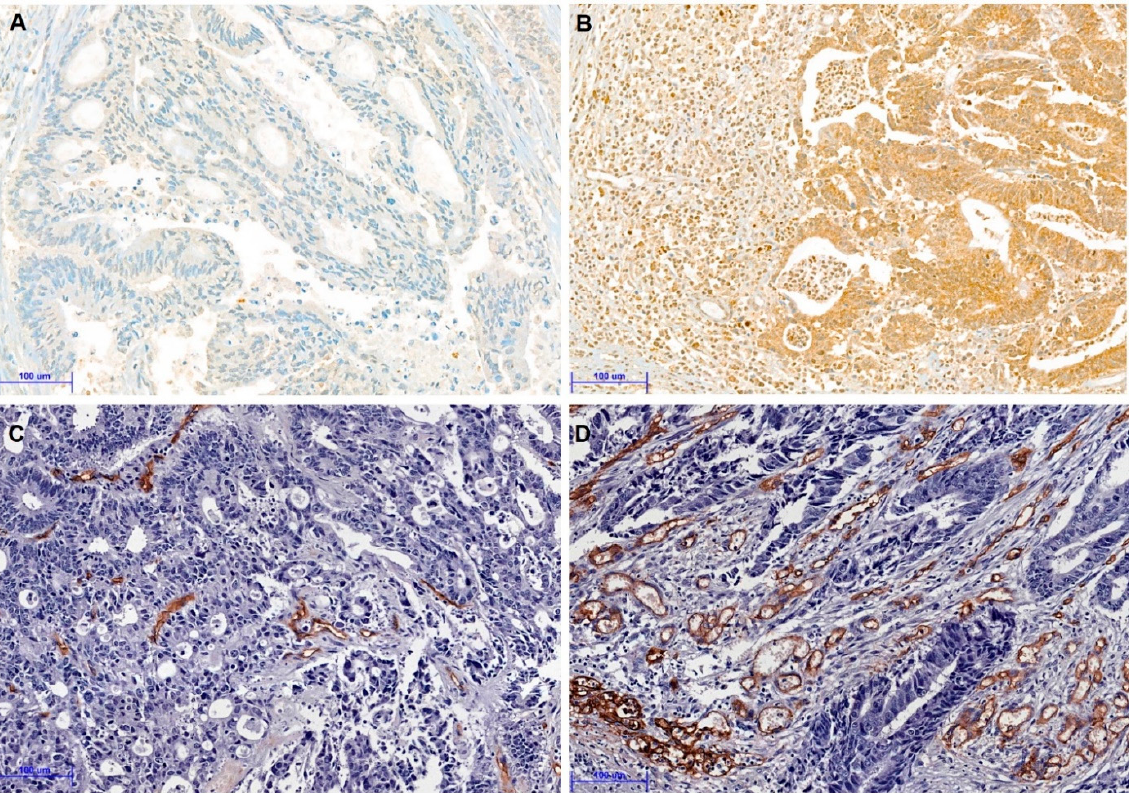
Figure 2. Representative immunohistochemical images for hypoxia-inducible factor-1 α (HIF-1 α ) and CD34 ( A – D ). ( A ) Negative expression of HIF-1 α in colorectal cancer with stroma-low (×200). ( B ) Positive expression of HIF-1 α in colorectal cancer with stroma-high (×200). ( C ) Low CD34 expression of microvessel density (MVD) in colorectal cancer with stroma- low (×200). ( D ) High CD34 expression of MVD in colorectal cancer with stroma-high (×200). (Scale bar = 100 μ m). Table 3. The correlation between tumor–stroma ratio and various factors in colorectal cancers. Stroma p- Value Low